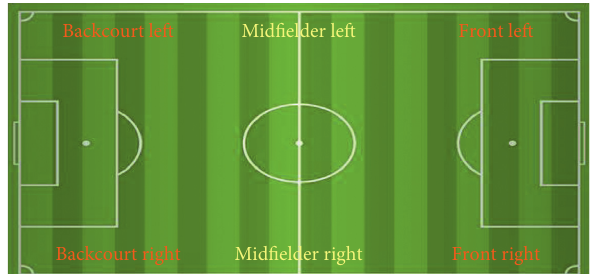
Figure 1: Regional division of football pitches (http://alturl.com/